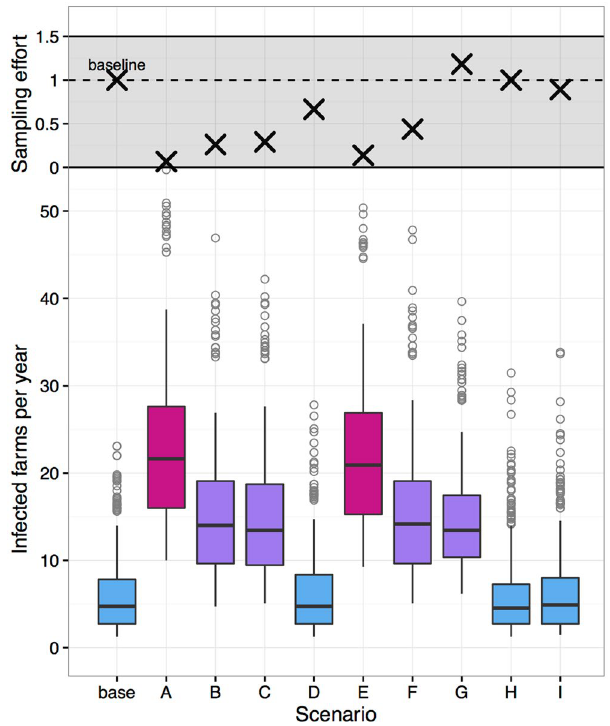
Figure 4. Comparison of sampling effort (top panel) and number of infected farms (bottom panel) for alternative surveillance strategies. Boxplot shows the number of farms infected per year (median, interquartile range, and 95 th percentile whiskers), and open circles represent outliers. Scenarios depicted with the same color were not significantly different based on a Kruskal-Wallis test. Sampling effort is calculated as the number of farms tested per year relative to the baseline scenario (~4,400 farms).